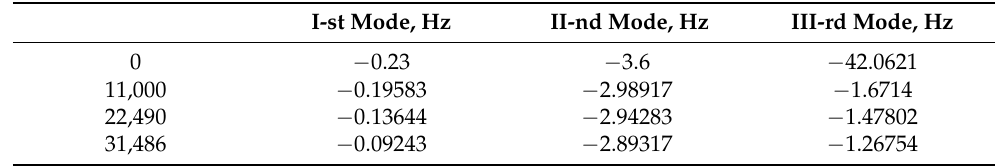
Table 5. Summary of differences between SP and SAL analyzes for different rotational speeds of the compressor vane.